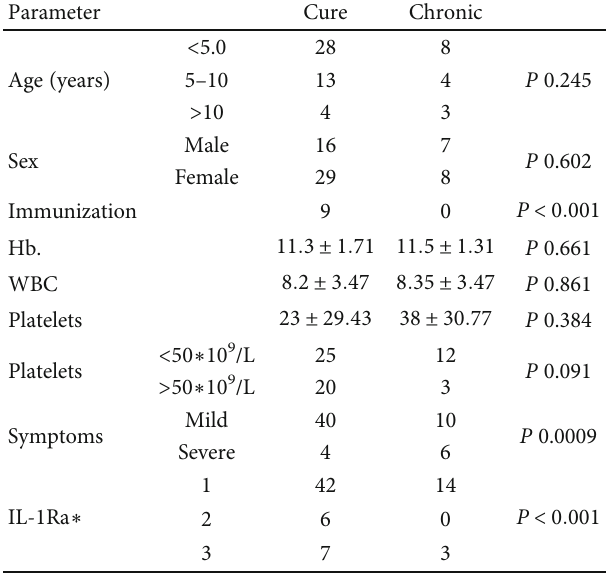
Table 4: E ff ect of various factors on remission achievement.